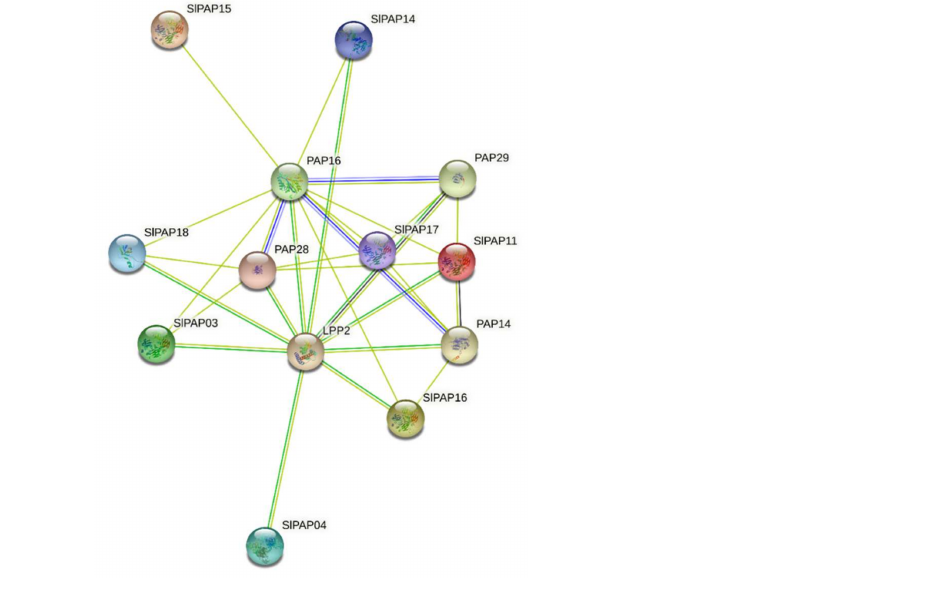
Figure 7. Functional interaction network of SlPAP proteins in tomato according to orthologs in Arabidopsis